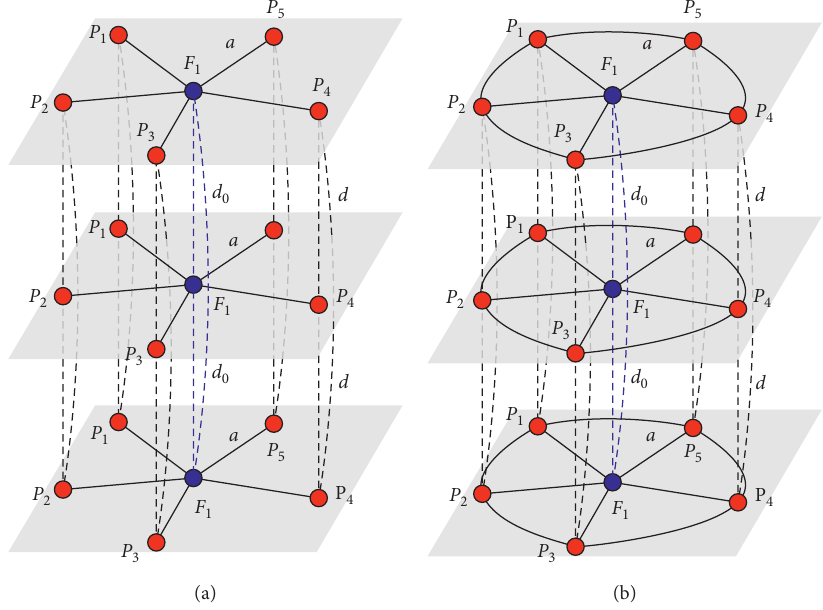
Figure 1: Schematic diagram of the network structure. (a) A three-layer star network structure. (b) A three-layer star-ring network